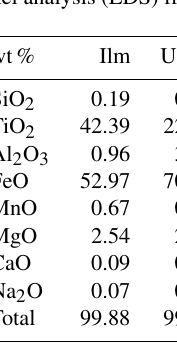
Table 5. Ilmenite and Ulvöspinel analysis (EDS) from sample